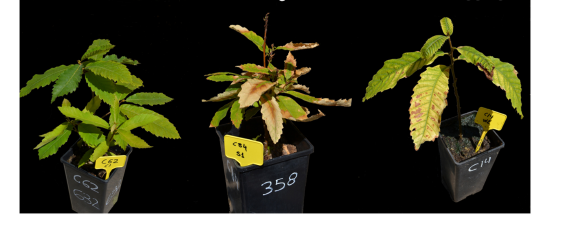
FIGURE5 Castanea sativa seedlings under regular watering (A) , drought (B) , and waterlogging (C) , from Camisón et al. (2020). Control plants present green and turgid leaves. Leaves of drought plants present wilting and some may fall. Dieback can be observed. Leaves of plants with waterlogging present chlorosis, chlorophyll degradation in the central part of leaves, necrotic borders and